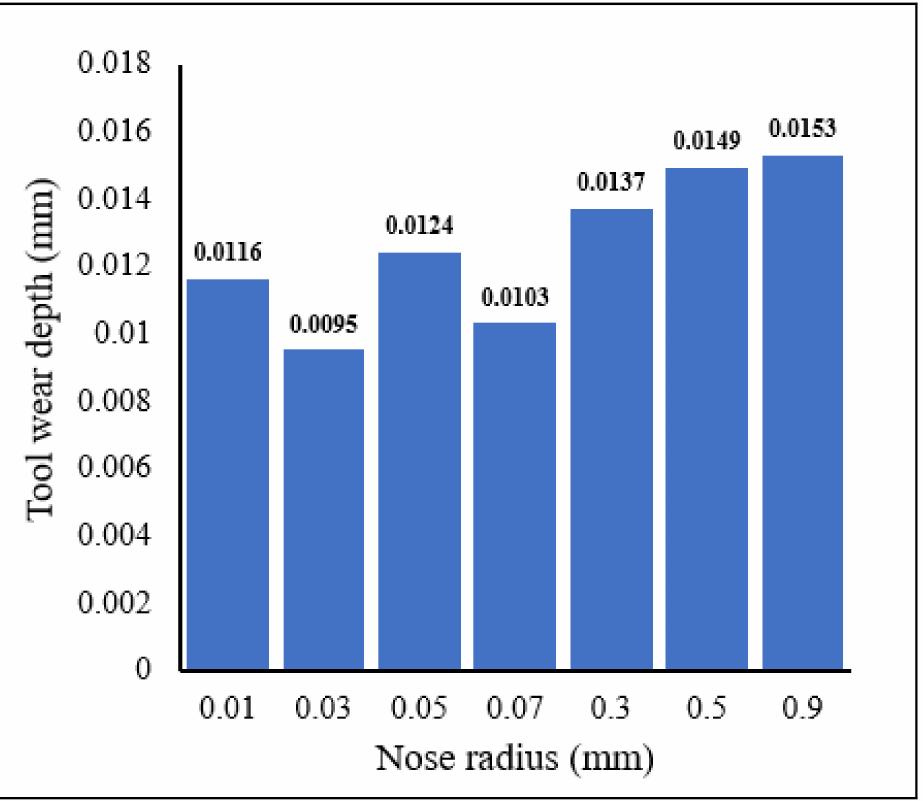
Figure 11. Distribution of tool wear for different tool nose radii V = 100 m/min, f = 0.1 mm/rev, γ = 5 ◦